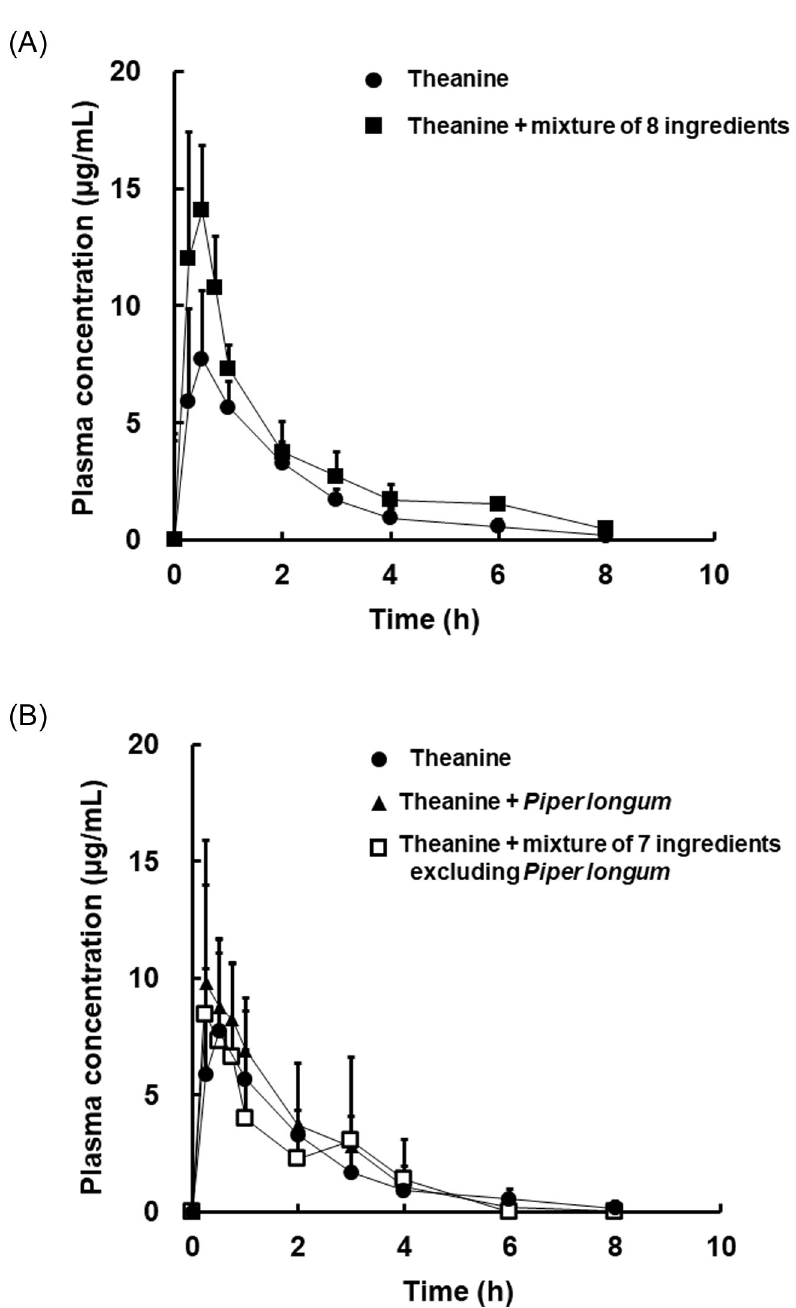
Fig 1. Plasma concentration of theanine after oral administration of theanine powder and/or a mixture of ingredients. Each point represents the mean with S.D. of 5–6 measurements. Powder of theanine in 0.5% methylcellurose (closed circle) and a mixture of theanine and eight ingredients (closed square) were administered (A). Powder of theanine in 0.5% methylcellurose (closed circle), a mixture of theanine and Piper longum (closed triangle), and a mixture of theanine and seven ingredients excluding Piper longum (open square) were administered (B). Blood samples were obtained up to 8 h after administration. The dose of theanine in all groups was 25 mg/kg body weight.